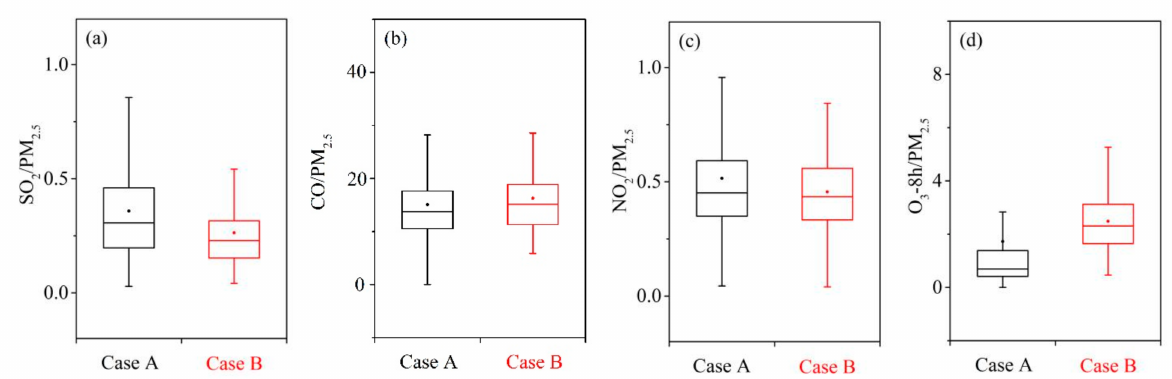
Figure 5. The ratio characteristics of air pollutants between Case A and B. ( a ) SO 2 /PM 2.5 , ( b ) CO/PM 2.5 , ( c ) NO 2 /PM 2.5 , and ( d ) O 3 /PM 2.5